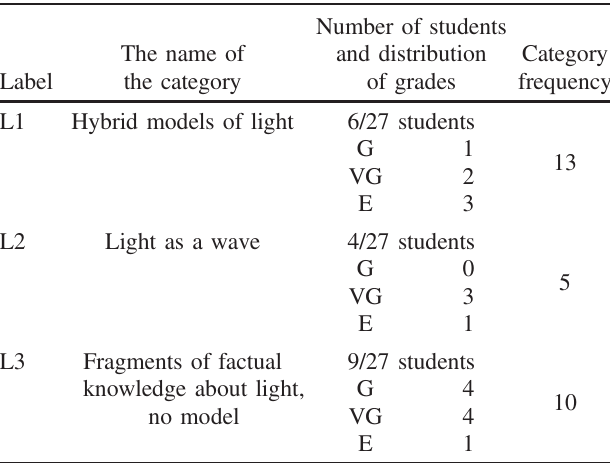
TABLE III. Categories of students ’ reasoning strategies and resources regarding the model of